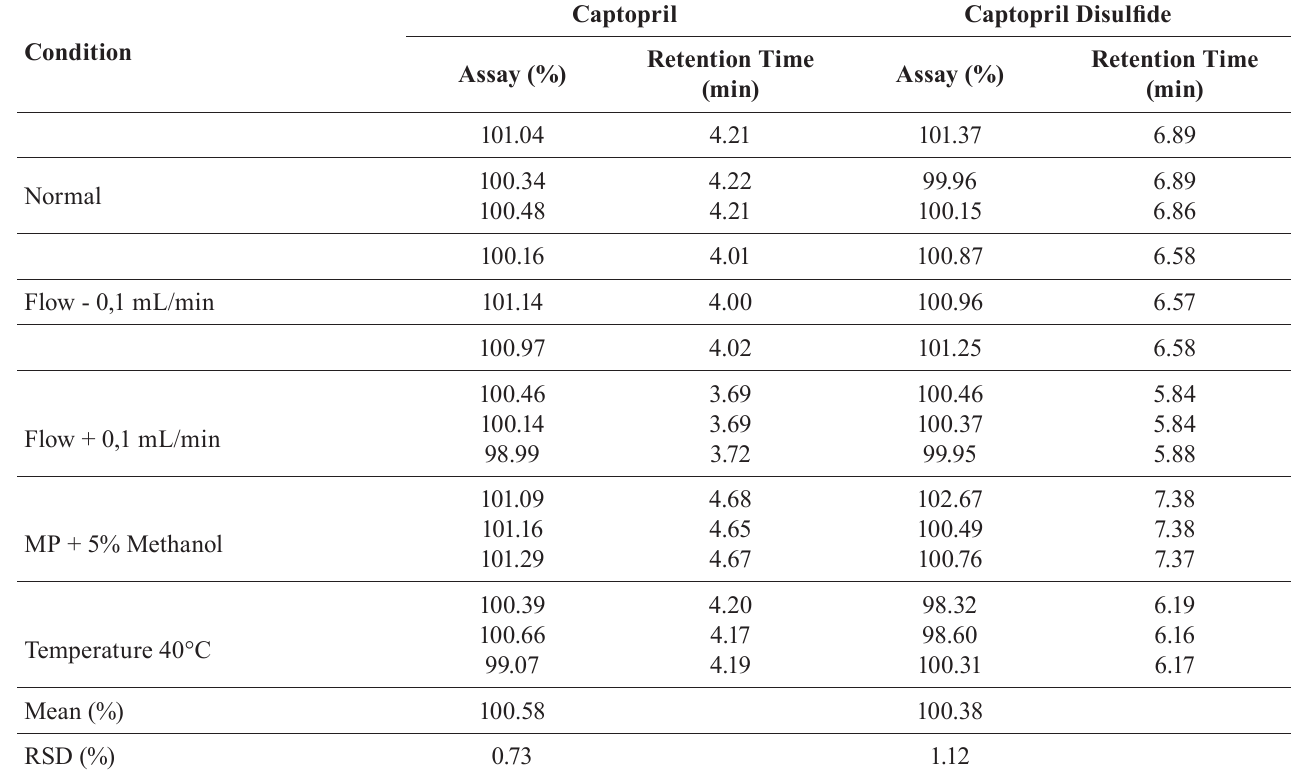
TABLE IV - Robustness